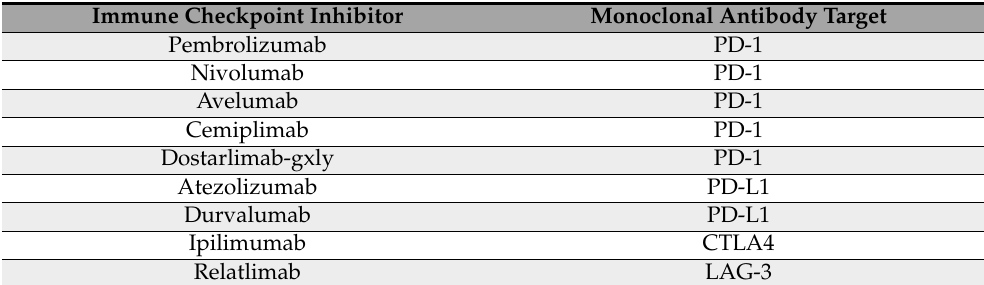
Table 1. FDA Approved Immune Checkpoint